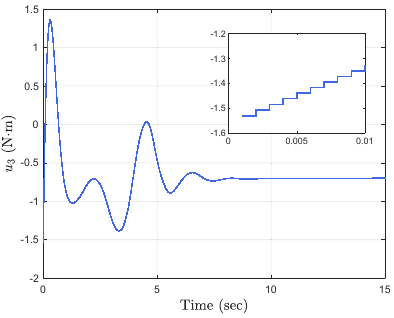
Figure 13. Time − triggered control input u 2 .